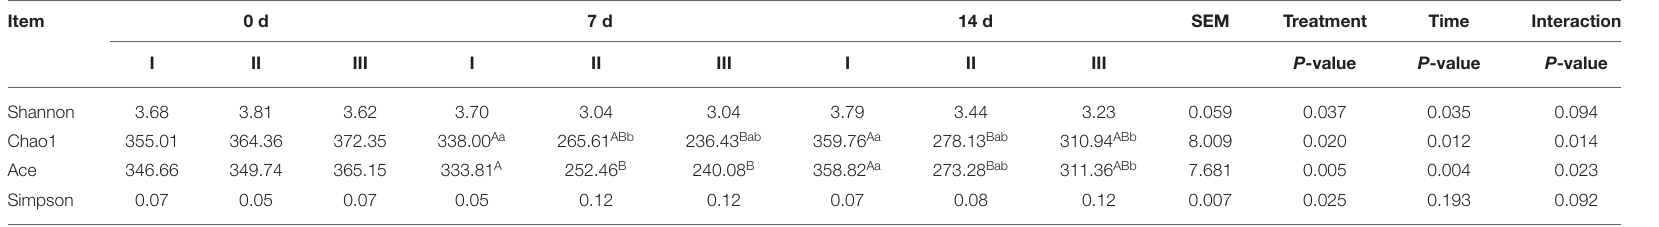
TABLE 5 | α diversity analysis results (Multiple comparisons between time at a specific